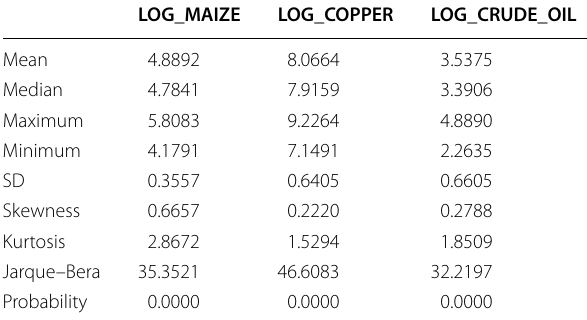
Table 1 Maize, copper and crude oil price trends 1982–2021